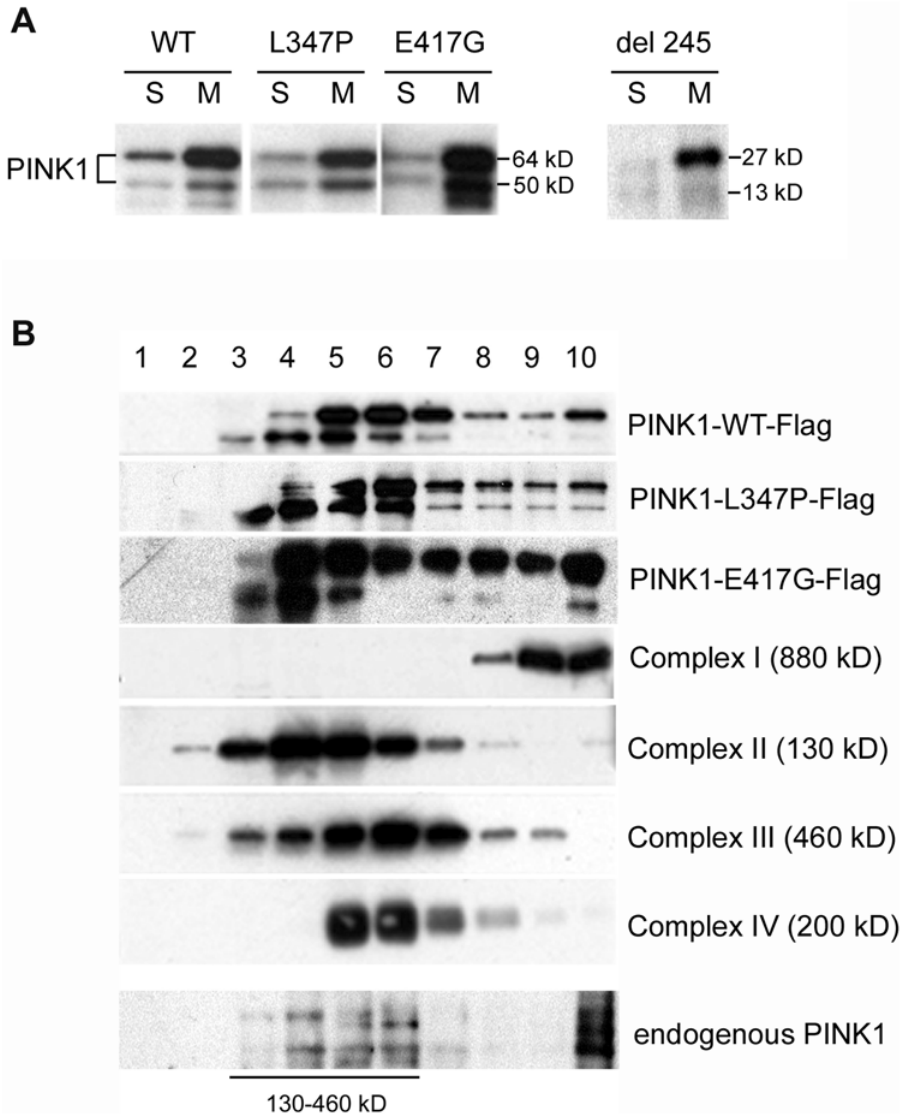
Figure 4. Recombinant and endogenous PINK1 are associated with protein complexes in mitochondria. In all experiments, adenoviruses of PINK1-Flag, L347P-PINK1-Flag, E417G-PINK1-Flag or Del 245 PINK1-Flag were infected into SH-SY5Y cells. A) Western blot analysis of PINK1 sub-cellular distributions with anti-Flag Ab. The two forms of PINK1 (a 64 kD full length protein and a truncated form of 50 kD, presumably a proteolytic product) are present in mitochondria and cytosol. The L347P, E417G or Del 245 mutant PINK1 did not affect this distribution. S: cytosolic fraction; M: mitochondrial fraction. B) PINK1 is associated with protein complexes. Mitochondrial proteins were sub-fractionated by 15% to 35% discontinuous sucrose gradient, from which fractions 1–10 were collected from top (lighter proteins) to bottom (heavier proteins or complexes). They were subjected to SDS-PAGE, and Western analyses with anti-Flag Ab for PINK1 (the top three panels); anti-39 kD protein Ab for complex I (4 th panel); anti-70 kD protein Ab for complex II (5 th panel); anti-core 2 Ab for complex III (6 th panel); and anti-cox I Ab for complex IV (7 th panel). No PINK1 was observed in lane 1 and 2, the fractions that contained proteins of the sizes for monomeric PINK1. Instead, PINK1 was associated with protein complexes ranging from 130–900 kD, which co-migrated with ETC complexes. The L347P and E417G mutations did not affect the PINK1 association and distribution of these complexes. More importantly, anti-human PINK1antibodies (Novus) detected endogenous PINK1 in SH-SY5Y cells with similar distribution along the sucrose gradient (bottom